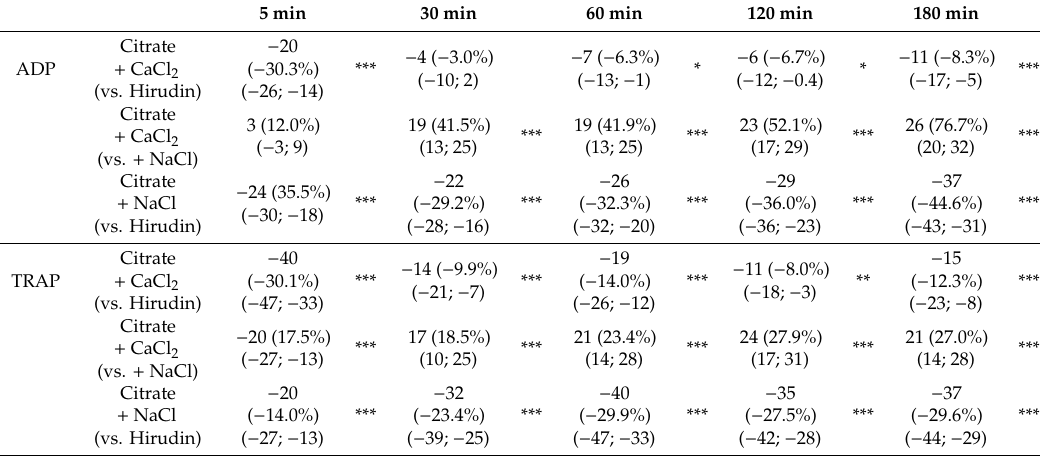
Table 4. Mean di ff erences in MEA results between the anticoagulants at the five time points. MEA values are expressed in arbitrary units with the two activators ADP and TRAP. Mean di ff erence, relative di ff erence (%) and 95% confidence interval for the mean di ff erence are given for each value.